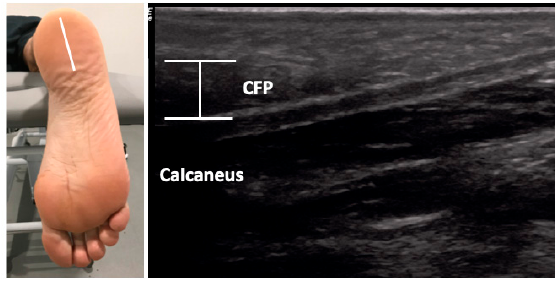
Figure 2. Ultrasound imaging thickness for the calcaneal fat pad in an individual with AT. Abbreviations: CFP, calcaneal fat pad.